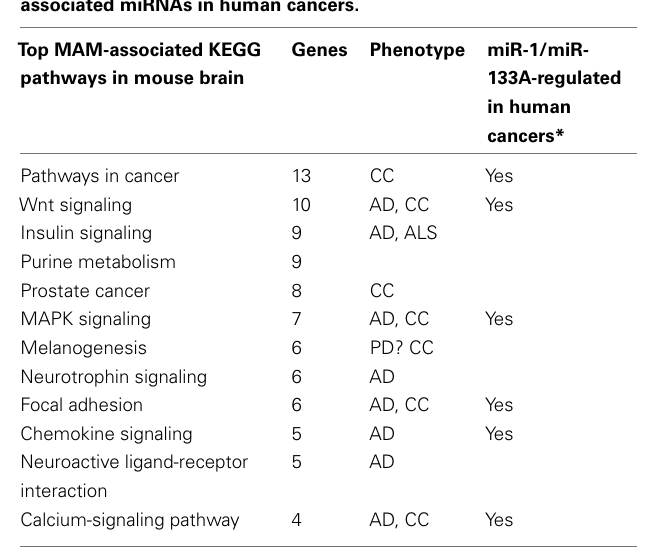
Table 2 |Top KEGG pathways in the brains of MAM-treated mice and associated miRNAs in human cancers.